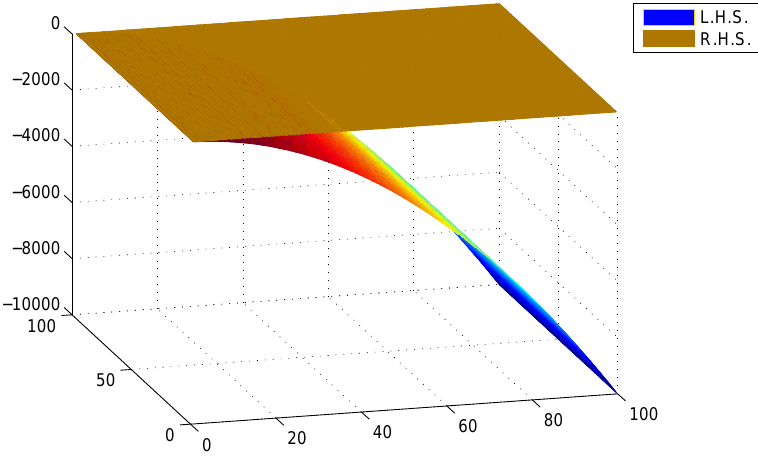
Figure 4. The value of comparison of L.H.S. and R.H.S. of Equation (20) in the 3D